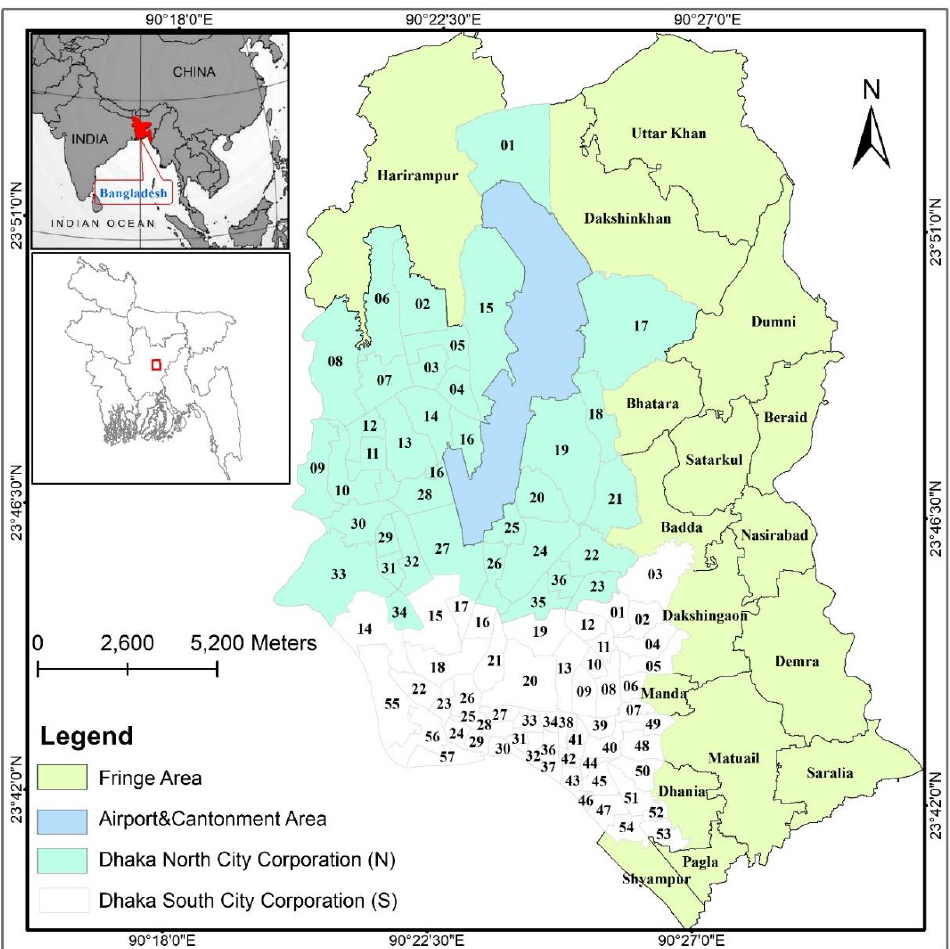
Figure 1. Location of Dhaka Metropolitan Area (DMA) with the distribution of the North City Corporation, South City Corporation, and Fringe areas. Sources: Bangladesh Bureau of Statistics (BBS), 2011, and Capital Development Authority (RAJUK), Dhaka, 2018. A B